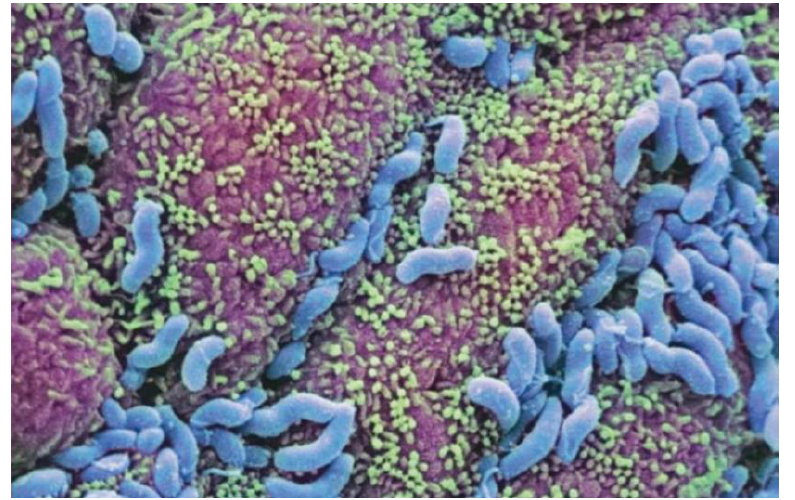
Fig. 1. Scanning electron micrograph images of H. pylori bacteria (in blue) (Abo Almaali, 2014). The urease enzyme and the heat shock protein B are located almost exclusively within the cytoplasm in the fresh